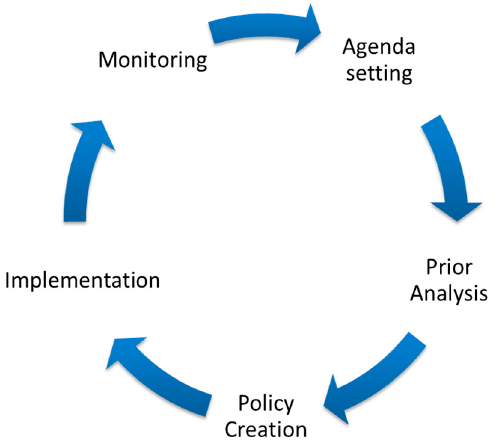
Figure 3. The Policy Cycle [11,19].